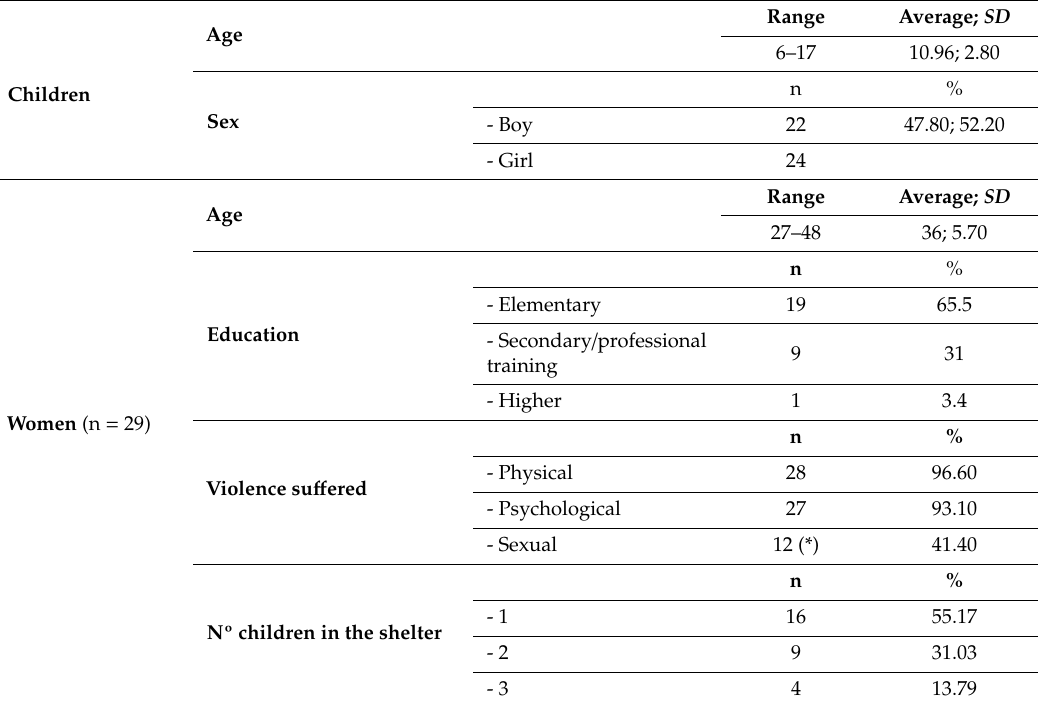
Table 1. Sociodemographic characteristics of the